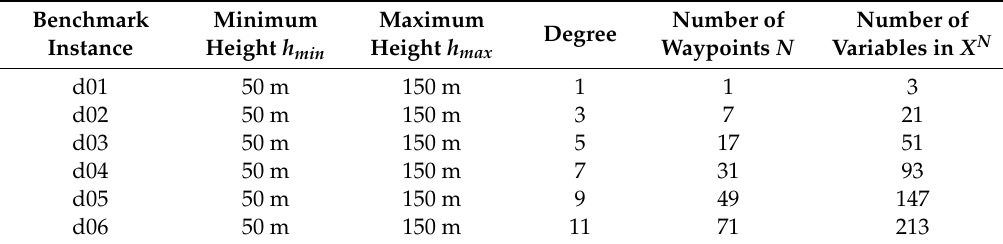
Table 3. Benchmark instances for verification of the deployment algorithm.